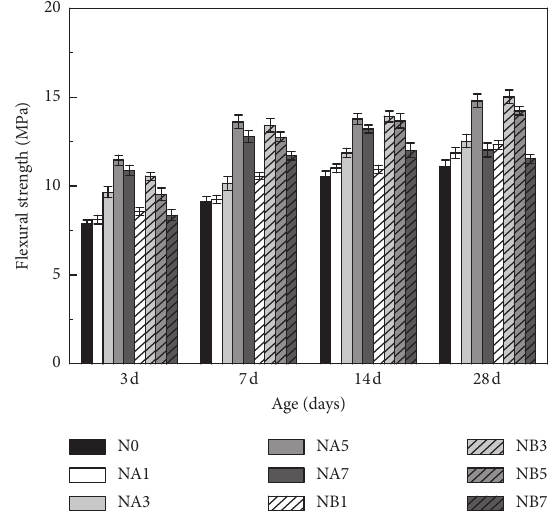
Figure 8: Flexural strength of the HCS samples at various curing